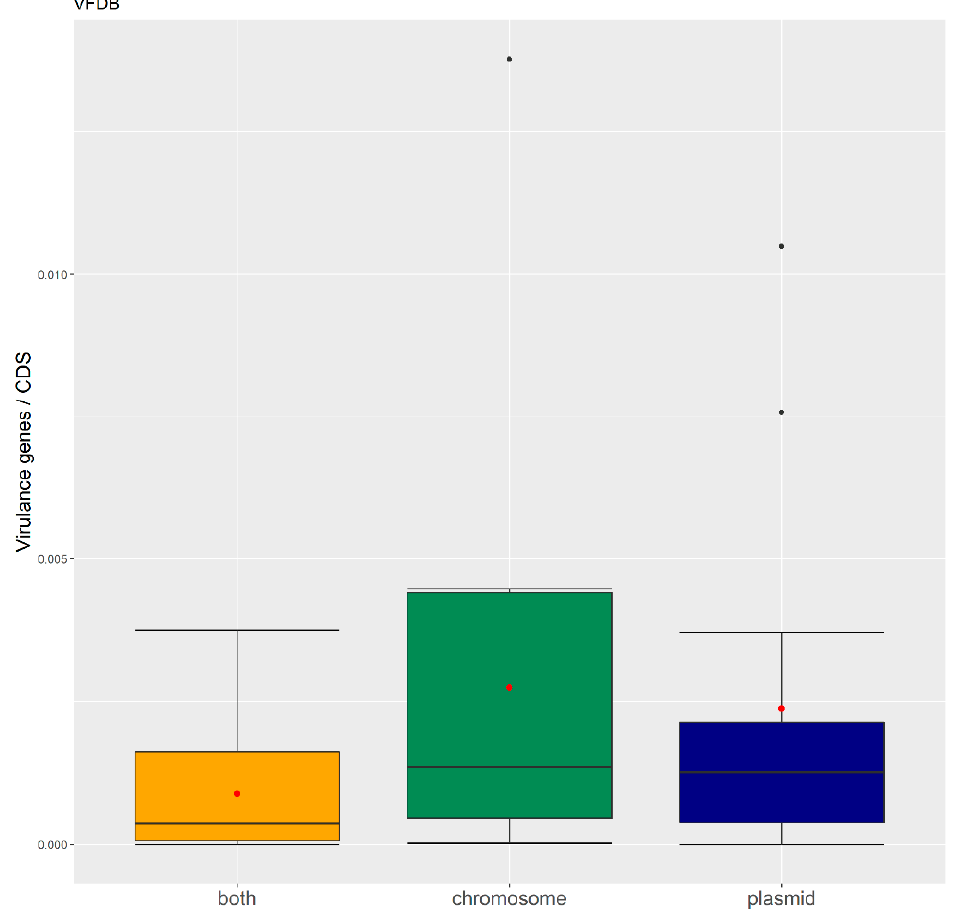
Figure 4. Boxplots of virulence factor orthologues per genomic location. The variance is higher in chromosomes (green). Orthologues found in plasmid (blue) and both (yellow) locations have similar variation. The red dot represents the mean.